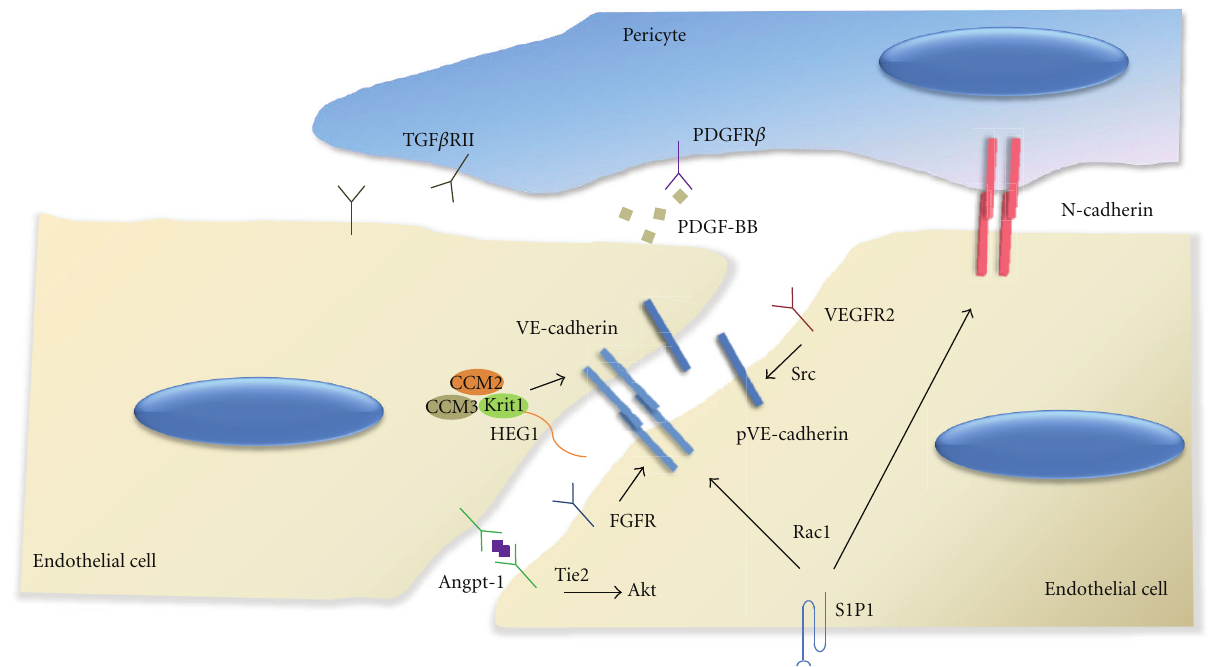
Figure 1: Signaling pathways controlling vascular maintenance. While VEGF signaling disrupts VE-cadherin-based junctions through Src- mediated VE-cadherin phosphorylation and internalization, FGF signaling promotes p120 association with VE-cadherin, thus increasing VE-cadherin stability at adherens junctions. Angpt-1 binding to Tie2 at cell-cell contacts leads to formation of Tie2 transdimers which activates Akt and promotes cell survival. S1P binding to S1P1 (Edg1) is able to stabilize endothelial junctions via Rac1 and promotes N-cadherin forward tra ffi cking required for endothelial-pericyte interaction. HEG1-CCM signaling at endothelial junctions enhances junctional stability through Krit1 interaction with β -catenin in the VE-cadherin complex. PDGF-BB secreted from endothelial cells recruit pericytes expressing PDGFR β . TGF- β produced in endothelial cells induces mural cell di ff erentiation. TGF β RII is also expressed in endothelial cells and controls various endothelial functions.